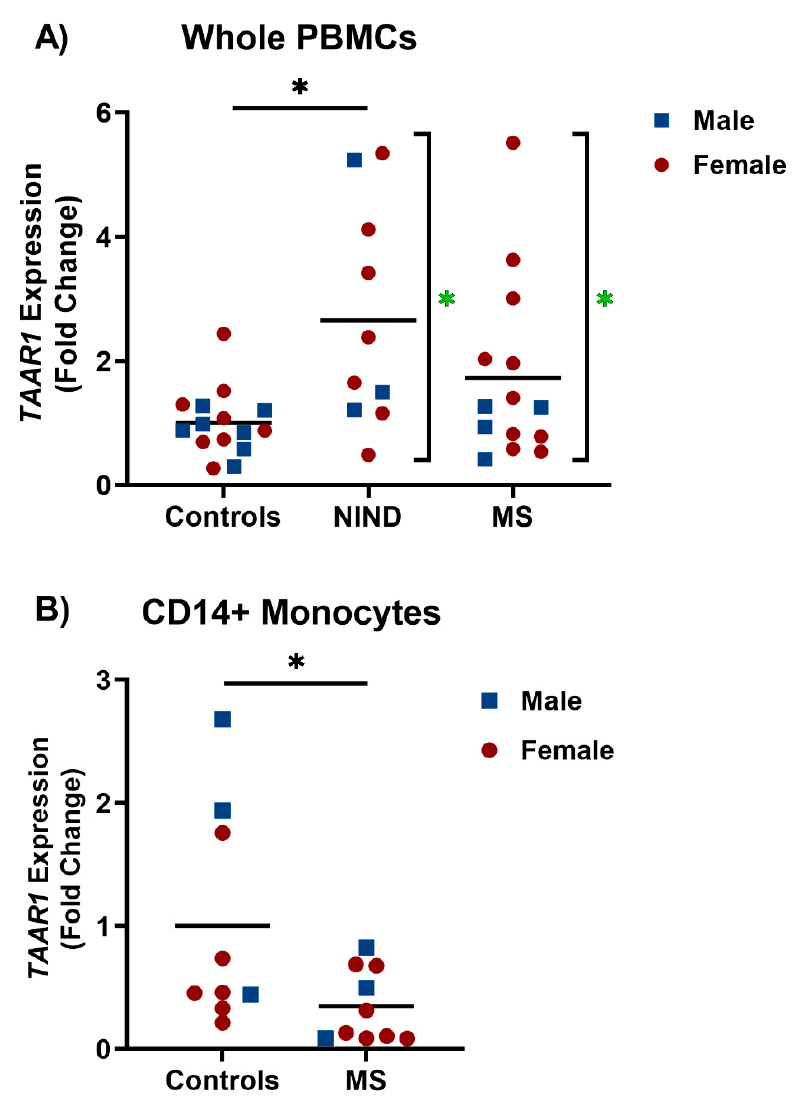
Figure 1. TAAR1 expression in multiple sclerosis (MS) whole peripheral blood mononuclear cells (PBMCs), CD14+ monocytes, and the respective controls. The ∆∆ CT method was used to compare TAAR1 expression to the GAPDH housekeeping gene. ( A ) Brown-Forsythe test showed significant differences between-group variances (* p = 0.0284, F = 4.284). Significant effects were therefore determined by the Kruskal–Wallis test with between-group comparisons by Dunn’s post-hoc multiple comparison test (* p = 0.0168 for NIND vs. Controls, p = 0.4130 for MS vs. Controls). ( B ) Two-tailed unpaired t test showed a significant difference between the groups (* p = 0.0424, t = 2.194, df = 17). Blue squares denote individual male participants; red circles denote individual female